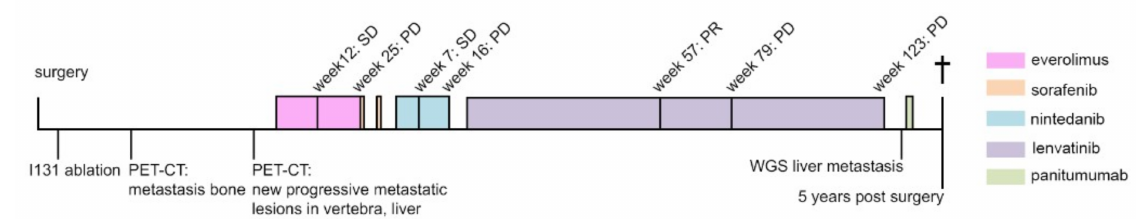
Figure 1. Timeline covering the final five-year-disease course of the present patient case. Having undergone standard therapy including surgery and radioactive iodine ablation, the patient developed progressive, metastatic, radioactive iodine refractory disease. An overview is depicted of administered targeted agents with evaluation of lesion response according to RECIST 1.1, first everolimus with SD at 12 weeks of use, PD 25 weeks, sorafenib for two weeks, nintedanib with SD at week 7, PD week 16, lenvatinib with PR at week 57, PD at week 79 and also week 123, and panitumumab for two weeks. WGS on metastatic material was done right before the last treatment regimen with panitumumab. PD, progressive disease. PR, partial response. SD, stable disease. WGS, whole genome